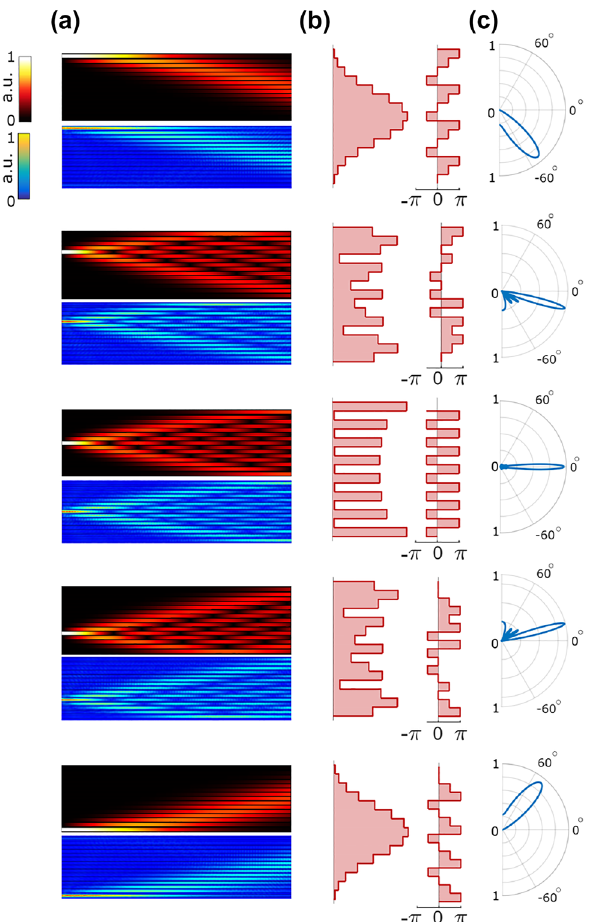
Figure 2: Exciting the waveguide array through different channels. (a) The longitudinal evolution of the field amplitudes through the waveguide lens. In each case, the results in the top panels are obtained through coupled-mode theory, while the bottom panels show two-dimensional finite-element simulations. (b) The magnitude and phase of the modal amplitudes at the output of the waveguide array. (c) The in-plane far-field radiation intensity patterns shown in polar plots with a linear radial